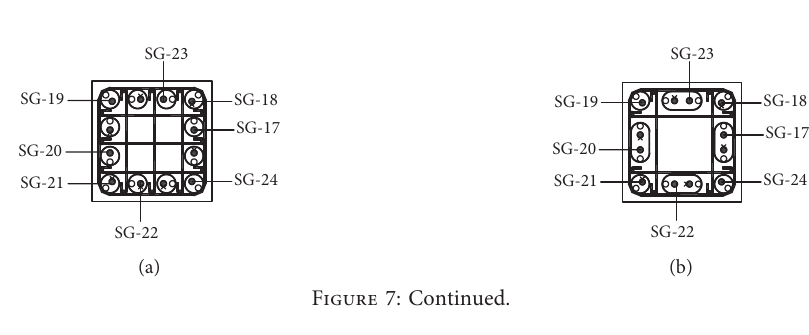
Figure 6: Loading history.